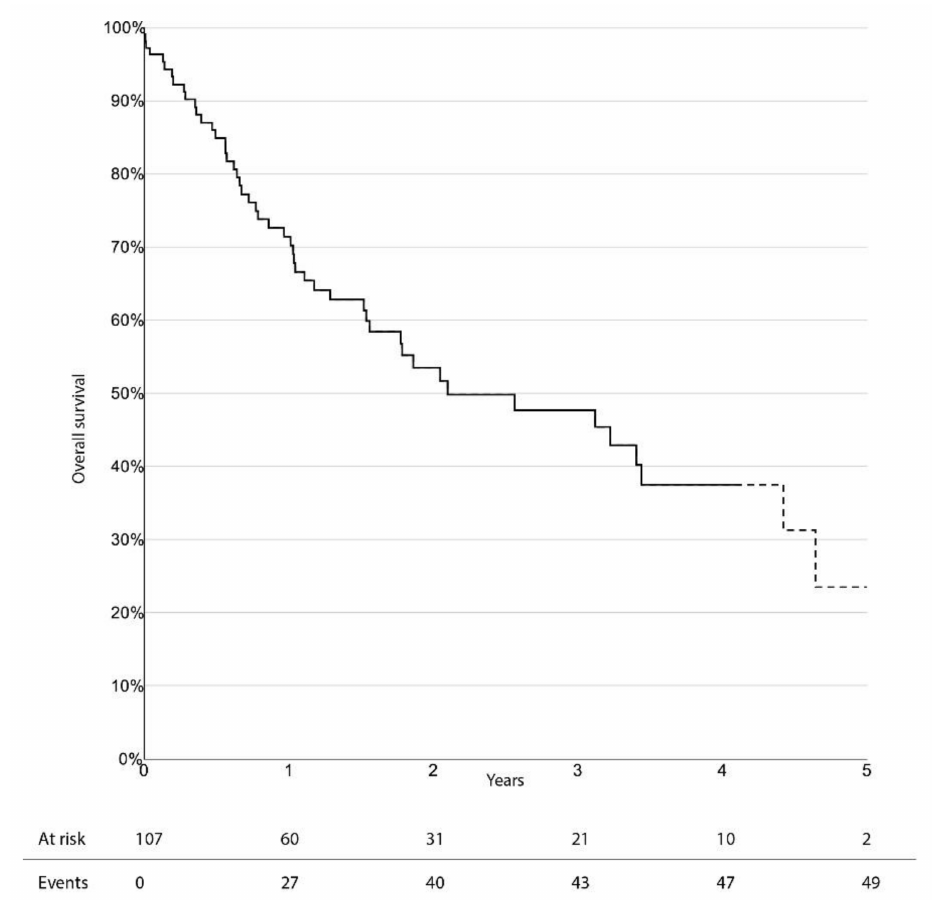
Figure 4. Survival estimate for overall